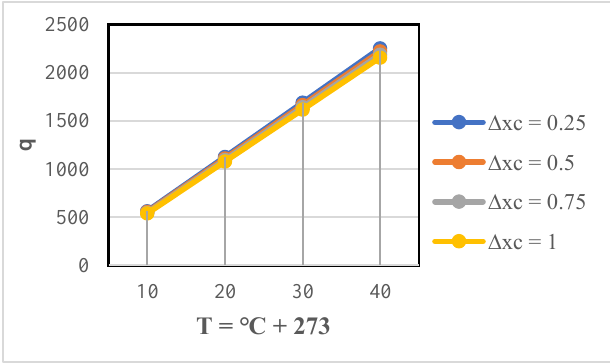
Fig. 5 Graphical presentation between heat flux and temperature at ∆𝑥 = 2 𝜇𝑚 , thickness of copper 𝑎